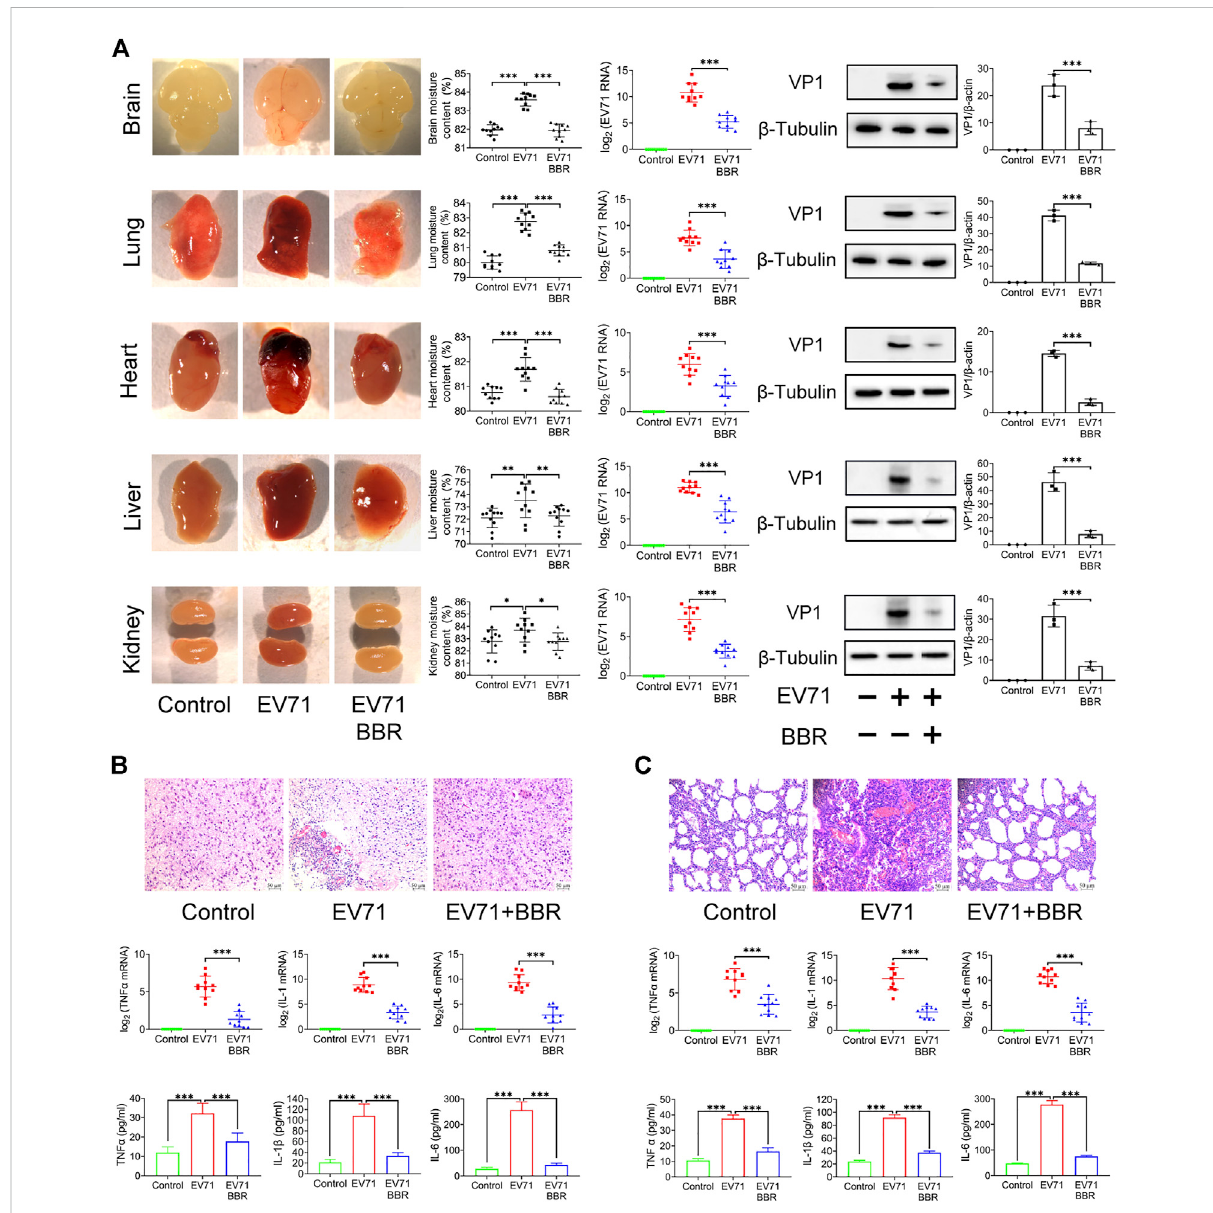
ReducedvirusreplicationandpathologicalinjuriesinEV71-infectedorgansafterBBRtreatment. (A) EffectsofBBR(5 mg/kg)onEV71replication and organ pathology in newborn mice. The moisture content of tissues was detected ( n = 10). EV71 RNA (copies) and VP1 protein expression levels were determined by qPCR ( n = 10) and Western blot analysis ( n = 3). (B) and (C) Effects of BBR on histopathological injury and expression of proin fl ammatory factors of brain and lung of the newborn mice. TNF α , IL-1 β ,and IL-6 mRNA and protein levels were determined by qPCR ( n = 10) and ELISA kits ( n = 6). Data are presented as SD. Statistical signi fi cance was compared between the test groups and the EV71 group was represented by asterisks marked correspondingly in the fi gures, *** p < 0.001 vs. EV71